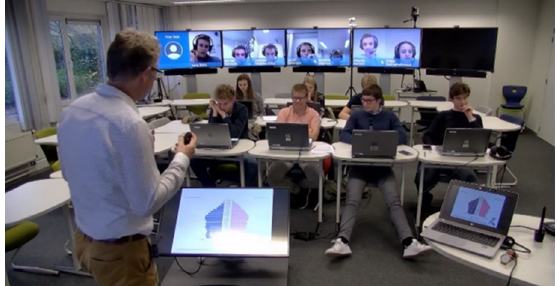
Figure 1. The hybrid virtual classroom, a relatively new learning space to synchronously connect remote and face-to-face